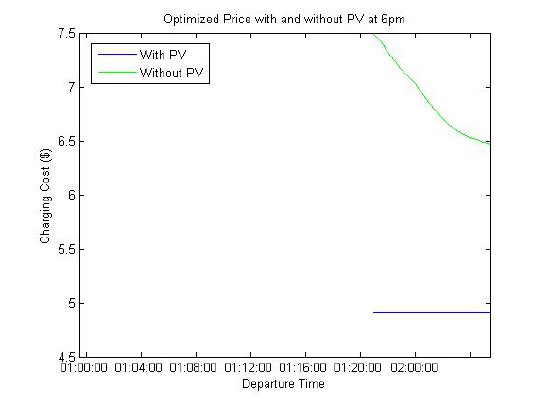
Figure 8: Optimized price with and without PV at 6pm.